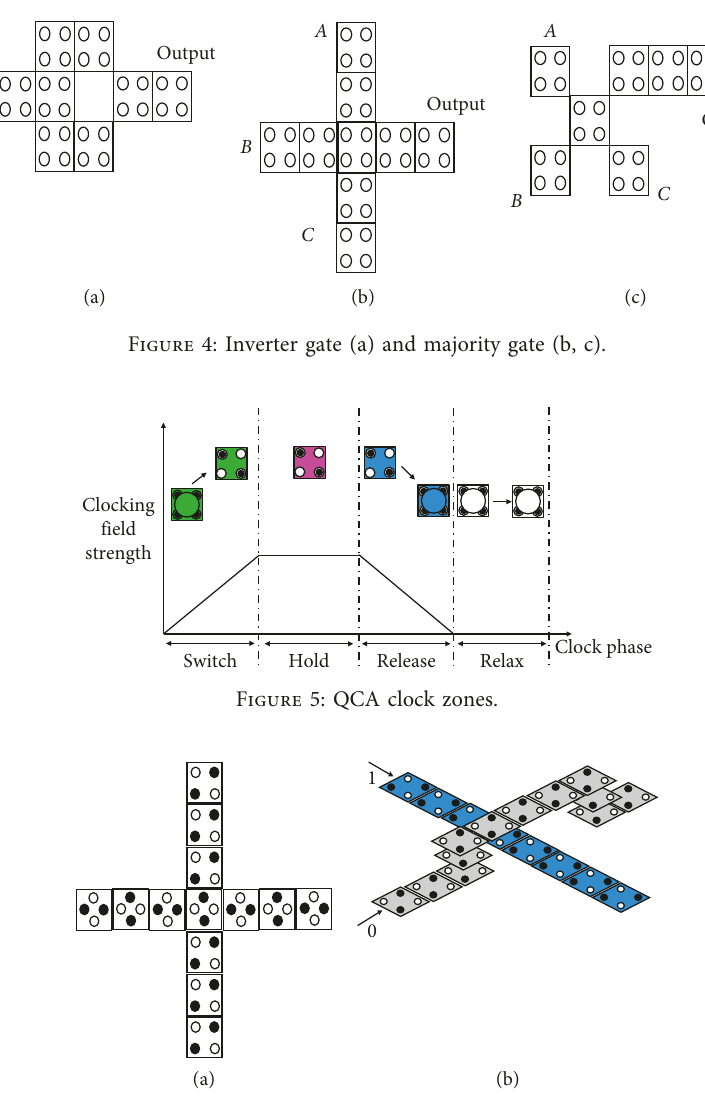
Figure 6: Signal crossover schemes: (a) coplanar crossing and (b) multilayer